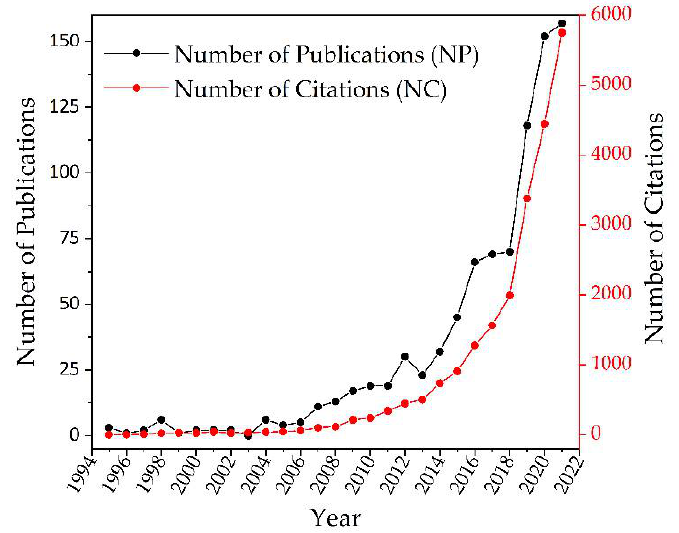
Figure 2. The trend of the number of publications (NP) and citations (NC) regarding PGPR enhancing salt tolerance in plants from 1995 to 2021.